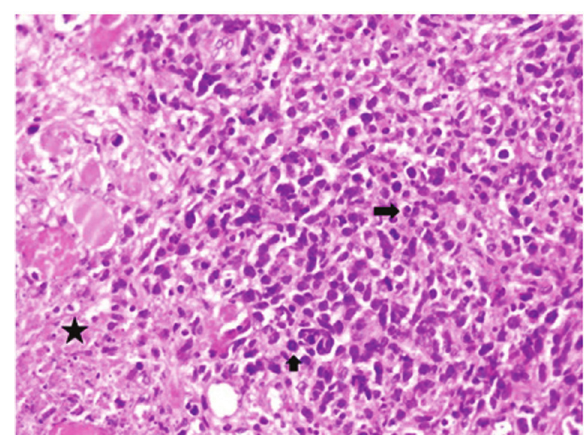
Patient having a midfacial wound.